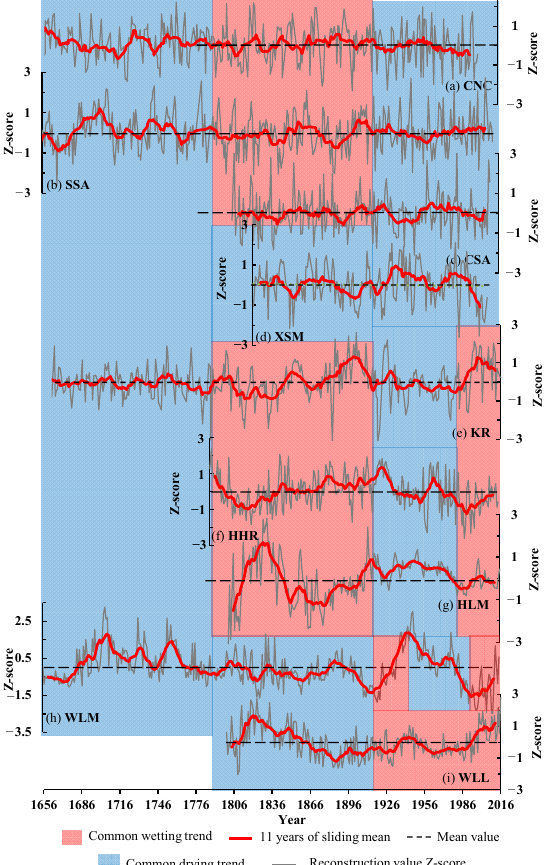
Figure 9. Comparison of the reconstruction results in this study and other reconstruction results for the joint area and the transition zone; ( a ) shows the exploratory precipitation in North-Central China during 1600~2000; ( b ) shows the reconstructed annual precipitation (SSA) during 1602~2014 in the Russian Far East (high-altitude area in the transition zone); ( c ) shows the annual precipitation (CSA) during 1804~2009 in the Russian Far East; ( d ) shows the reconstructed annual precipitation (XSM) during 1829~2013 in the Hulunbuir area in Northeast China (middle-altitude area in the transition zone); ( e ) shows the reconstructed summer precipitation series (KR) during 1650~2015 in Tajikistan (located in the west of the central Asian westerly); ( f ~ i ) are the reconstruction results of this